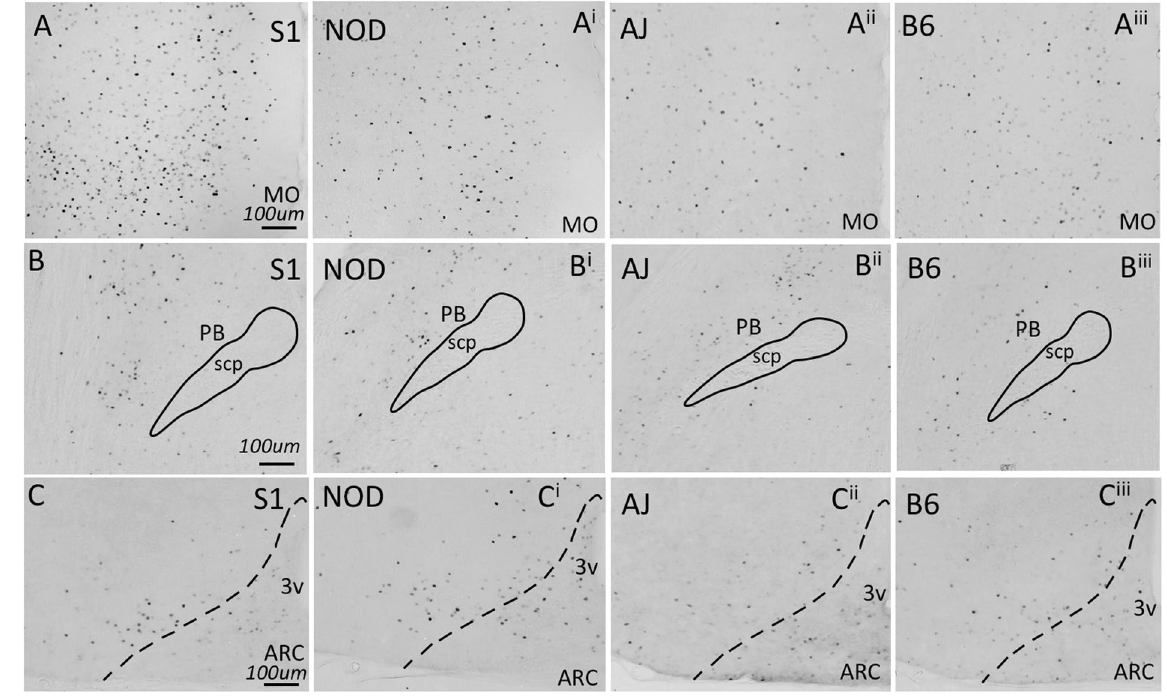
Figure 5. Examples of cFos expressing brain areas from all four mouse strains challenged with HCD, as quantified in Fig. 3. Increased cFos expression was observed in the MO ( A ) and PB ( B ) across mouse lines, while little change in cFos expression was observed in the Arc ( C ).